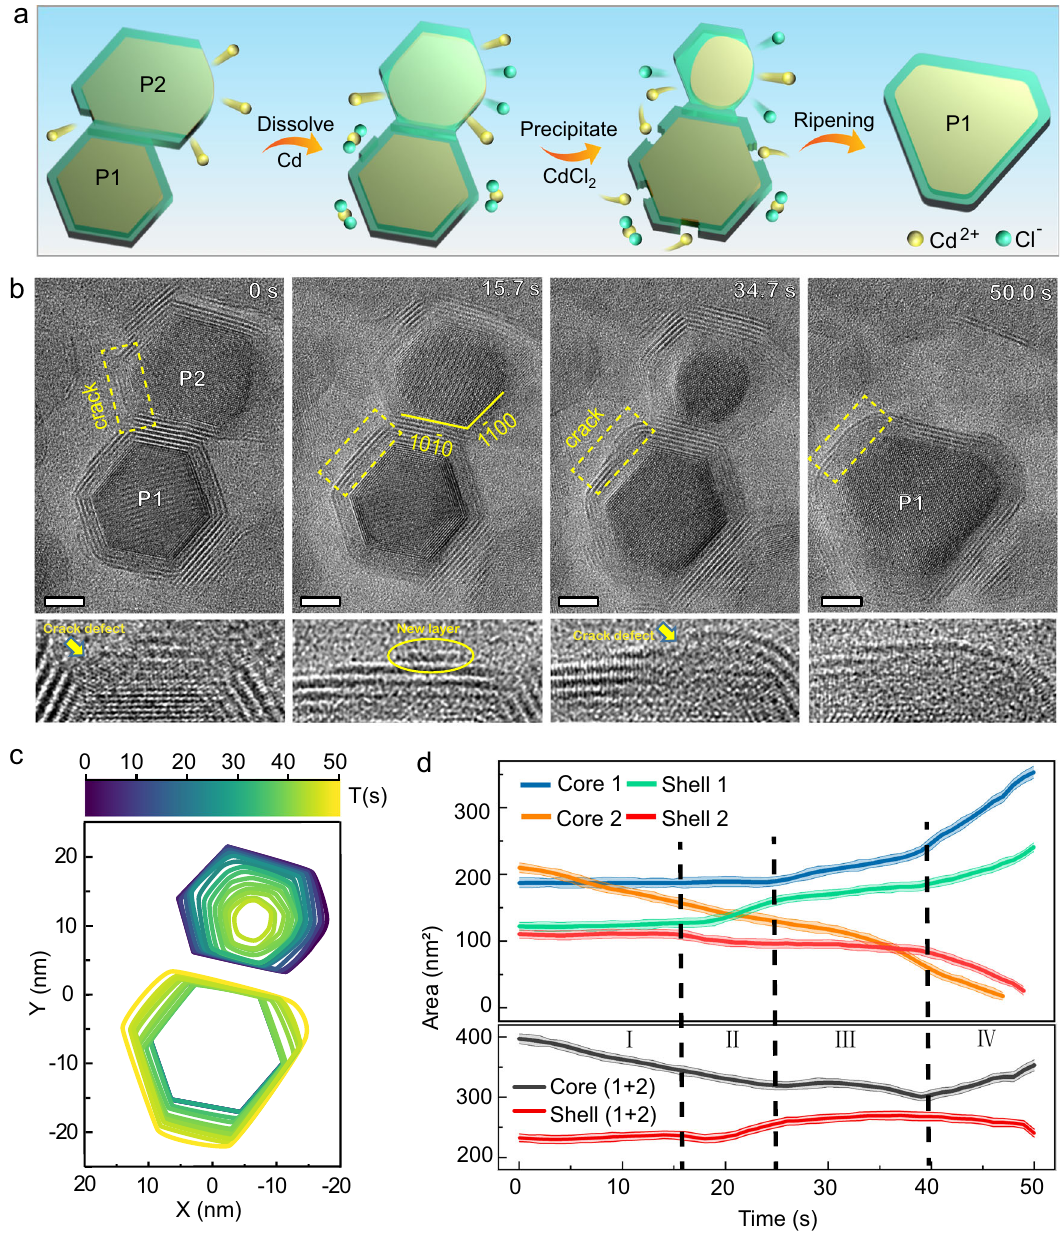
Fig. 2 The defect-mediated ripening process of Cd-CdCl 2 core-shell nanoparticles. a Schematic illustration of the evolution pathway of Cd-CdCl 2 core- shell nanostructures during the defects-mediated ripening. b Sequential images show the ripening process after two Cd-CdCl 2 core-shell particles are connected. P1 and P2 mark out the two particles. Scale bar, 5 nm. The enlarged images of the yellow square areas listed below highlight an incomplete shell, a new CdCl 2 layer, a new crack defect and healing of the shell. c The colored contours indicate the shape evolution of the two cores. d The measured projected areas of the core and shell for P1 and P2 as a function of time. I, II, III, and IV refer to the four intervals of the dynamic process. The transparent lines around the solid lines indicate the standard deviation error of the